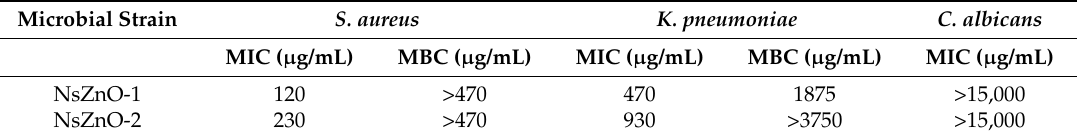
Table 3. Minimum inhibitory concentration (MIC), and minimum bactericidal concentration (MBC), of NsZnO-1 and NsZnO-2 determined for S. aureus , K. pneumoniae , and C. albicans expressed in μg/mL. Minimum fungicidal concentration (MFC) for C. albicans was not determined.